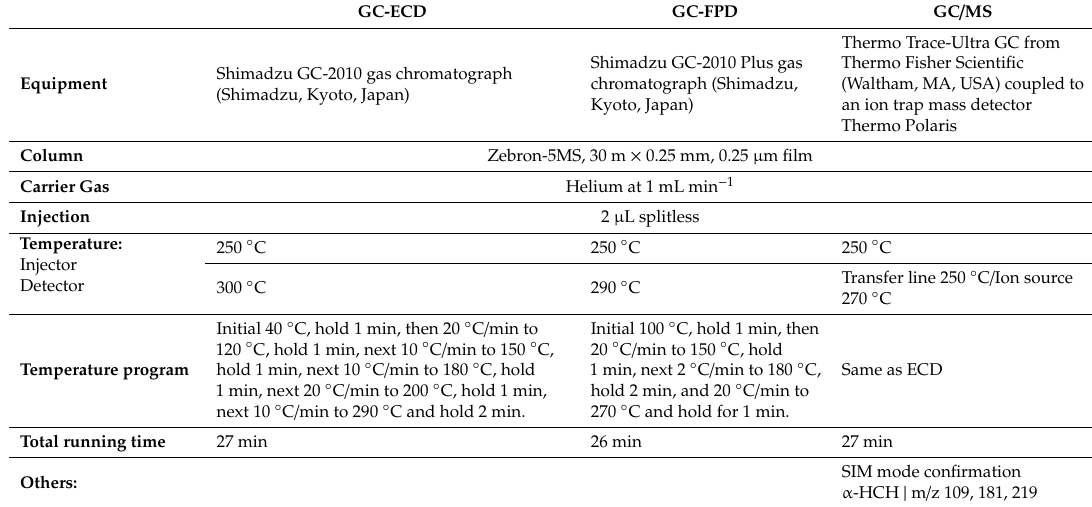
Table 1. Summary of gas chromatographyGC conditions for the analysis of 20 pesticides.